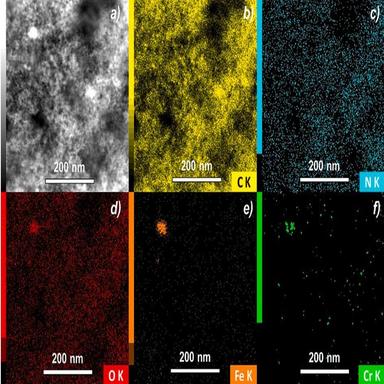
a) High angle annular dark field (HAADF) STEM image of a selected area of the as-received DND, and b–f) corresponding EDX spectroscopy elemental mappings. Carbon signal is shown in yellow (b), nitrogen in light blue (c) and oxygen in red (d). Iron (e) and cobalt (f) are respectively represented by orange and green colors. (For interpretation of the references to colour in this figure legend, the reader is referred to the web version of this article.)